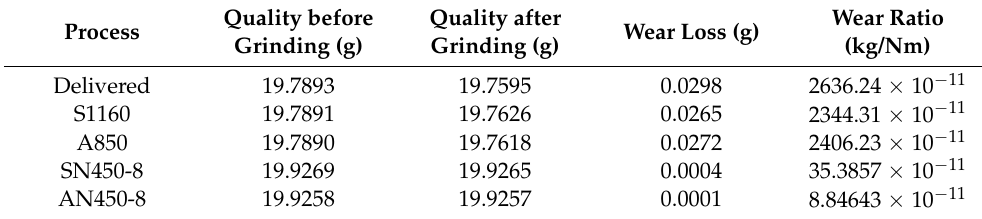
Table 4. Weight loss and wear ratio of AISI 430 stainless steel with a different initial microstructure before and after low-temperature plasma nitriding.